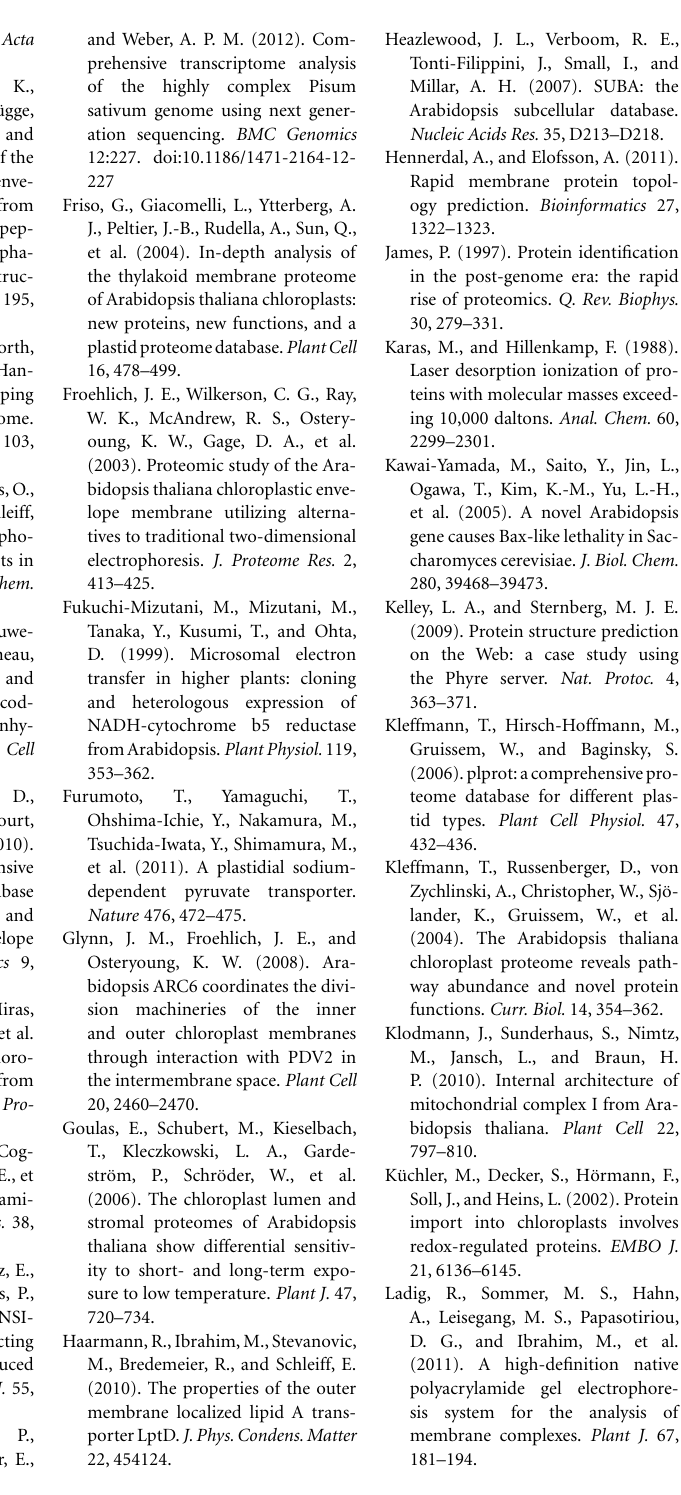
sixth column the number of protein groups, the seventh column the activation type (Collision Induced Dissociation, CID), the eighth column the modifications, the ninth column the ion score, the 10th column the expectation value (exp. value), the 11th column the delta score ( ∆ score), the 12th column the rank, the 13th column the identity High, the 14th column the homology